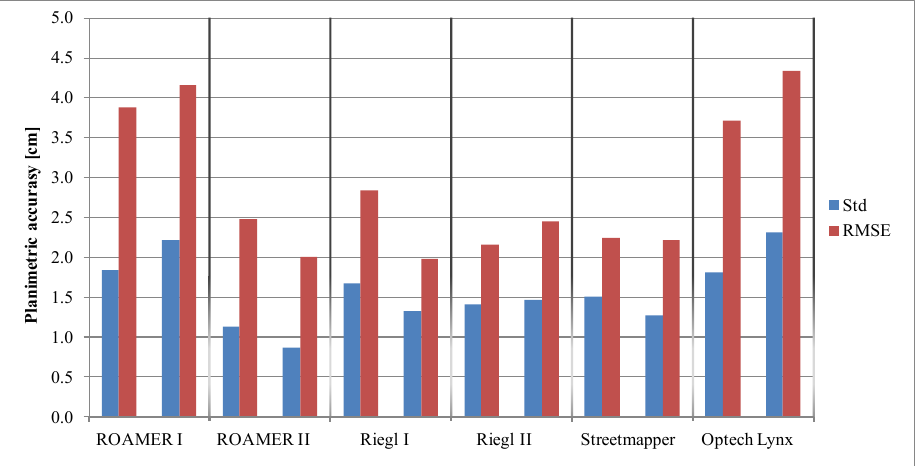
Figure 17. The planimetric accuracy of the tested MLS systems in two driving directions. The left column stands for counter-clockwise, CCW, and the one on the right for clockwise, CW, direction.